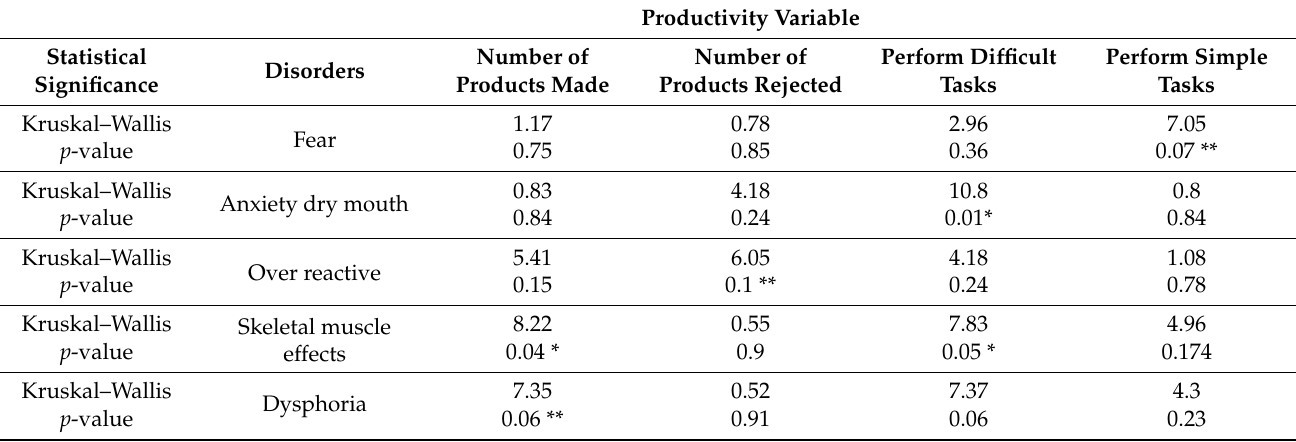
Table 4. Significance levels according to the ANOVA statistic in the relationship between